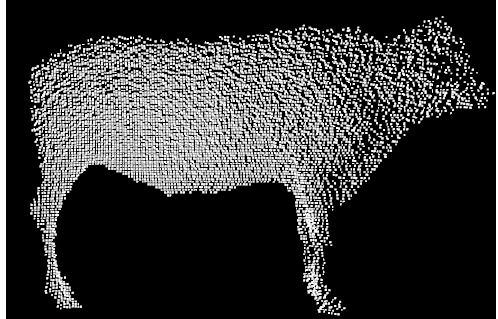
Figure 7. Segmentation with Euclidean clustering and RANSAC, where most of the background adherent to cattle has been canceled.